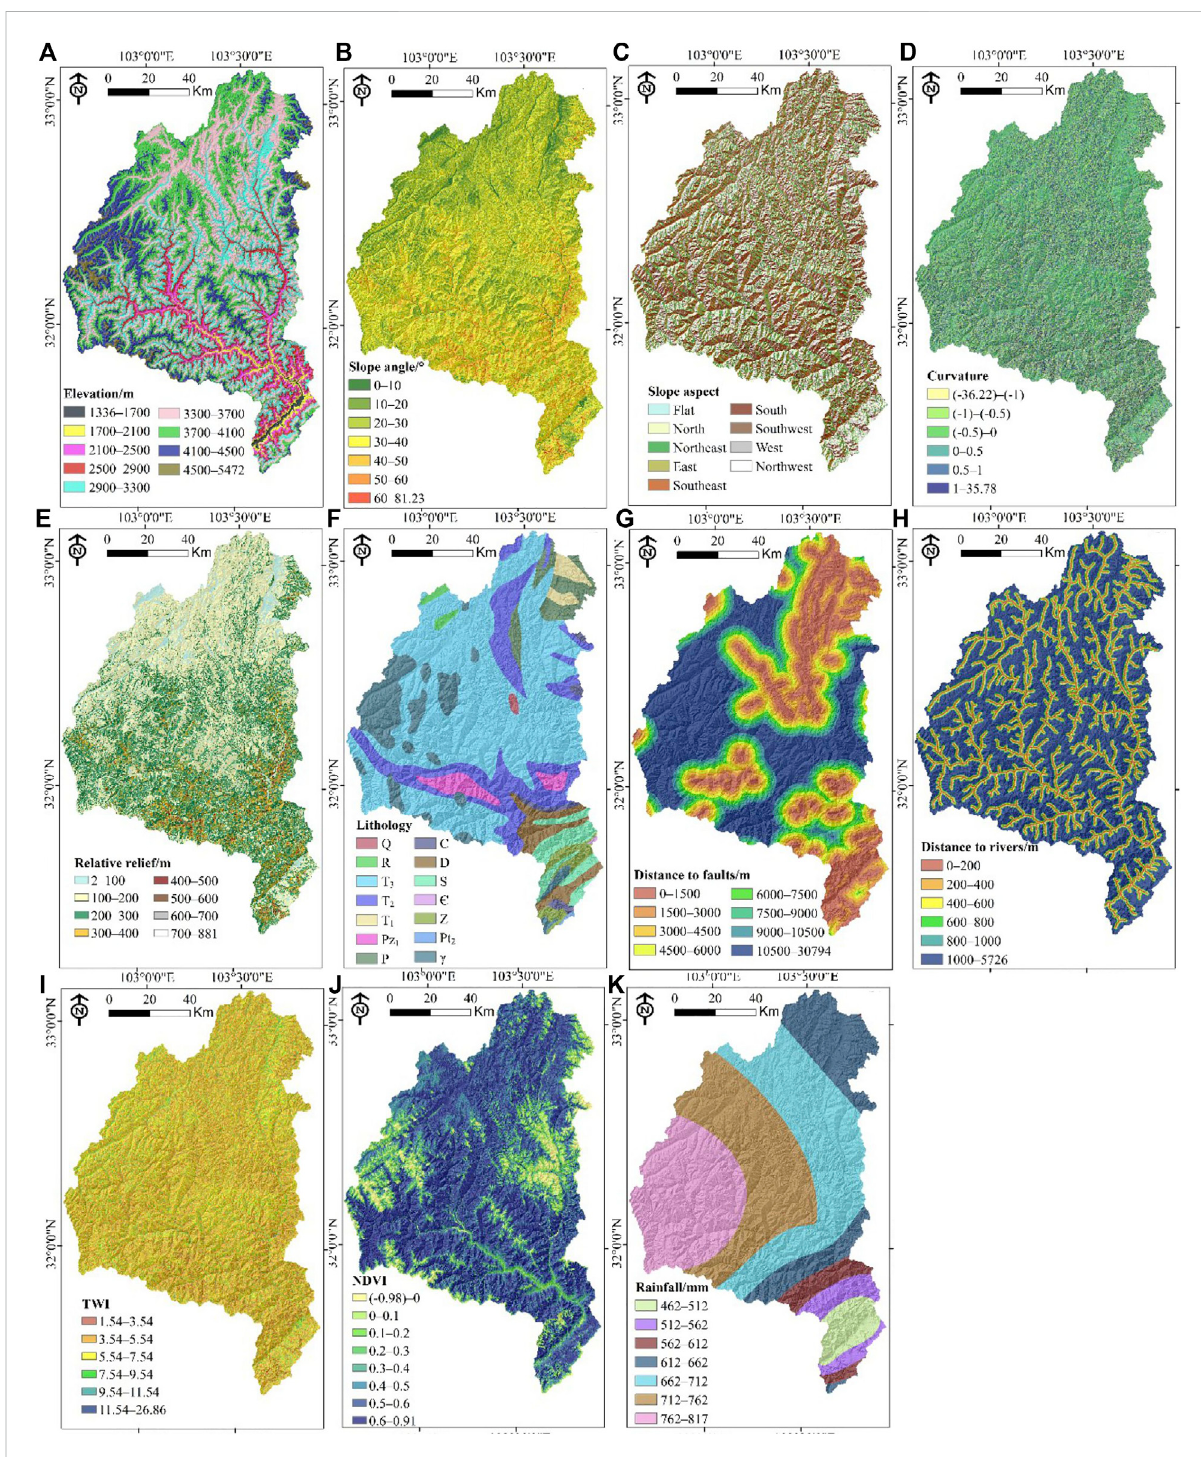
FIGURE 3 Landslideconditioningfactors: (A) elevation, (B) slope angle, (C) slopeaspect, (D) curvature, (E) relativerelief, (F) lithology, (G) distance tofaults, (H) distance to rivers, (I) topographic wetness index (TWI), (J) NDVI, and (K)